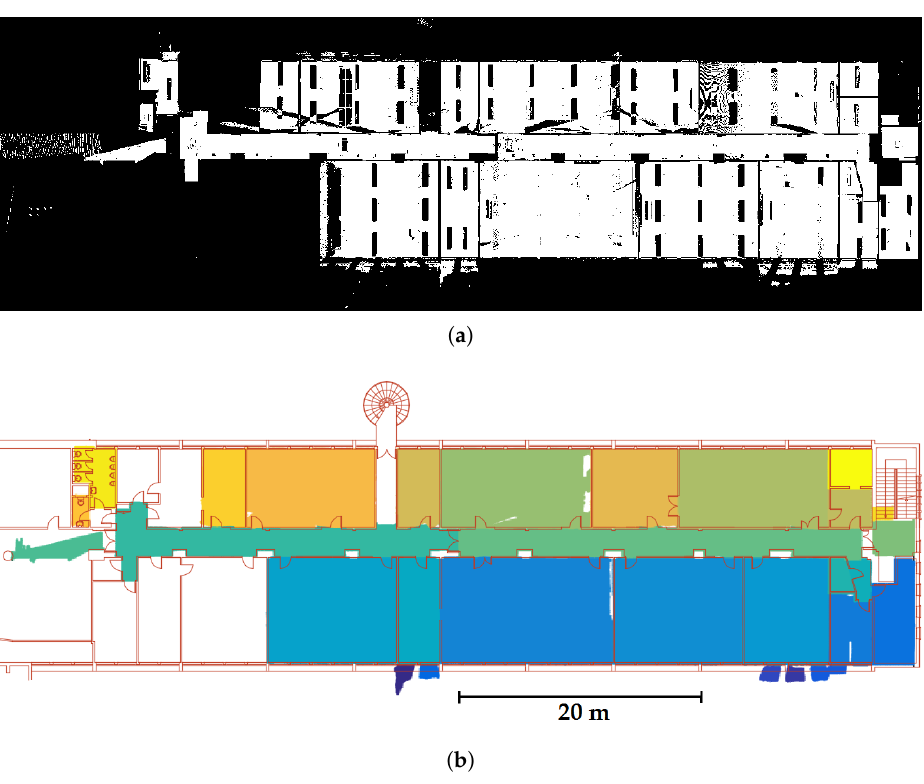
Figure 4. Room segmentation: ( a ) Generated binary image for the 1st floor of the INSA building. ( b ) Region growing result superimposed with an existing floor map in